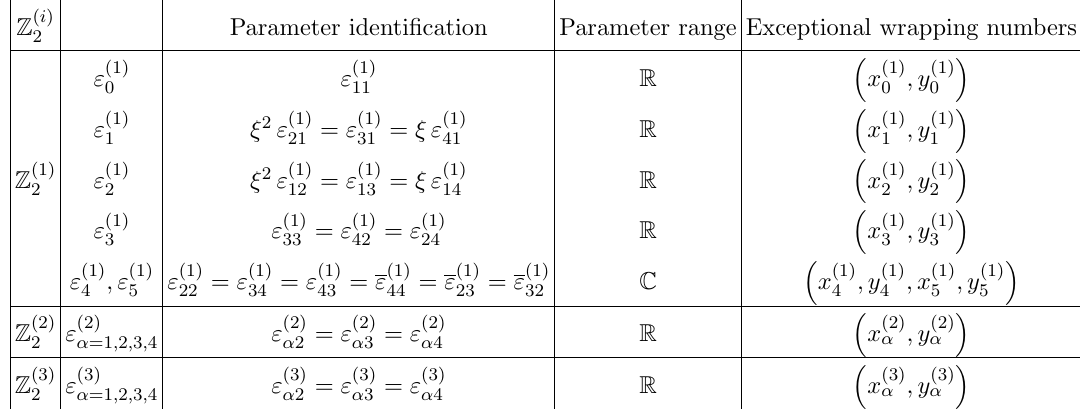
-twisted sector for 2